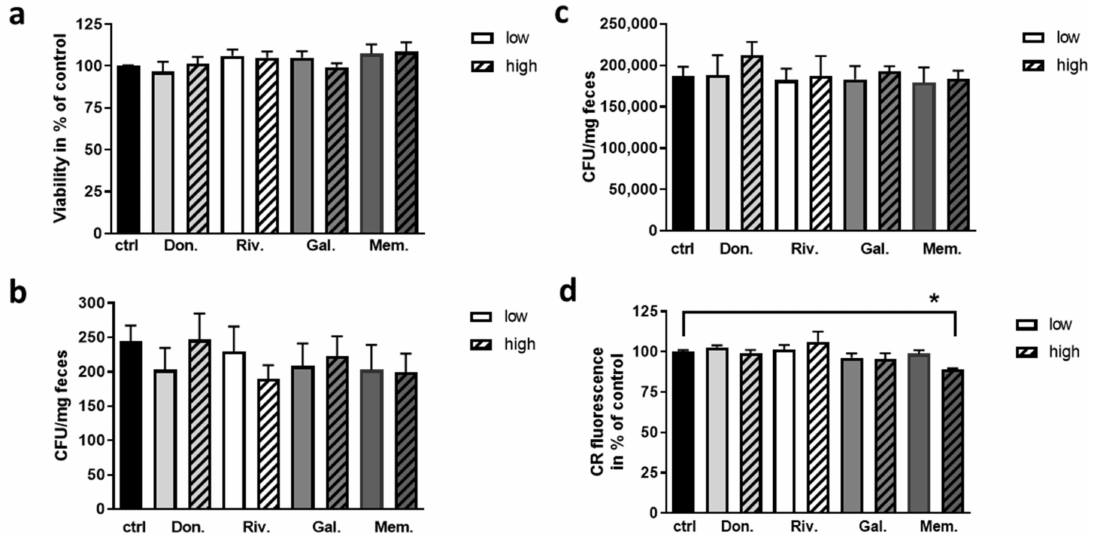
Figure 1. Effect of AD therapeutic drugs on growth and biofilm formation of bacteria. ( a ) Fresh fecal samples from wild type C57BL6/J mice were collected, diluted appropriately and incubated with the respective drug for 10 min (ctrl: DMSO; Don.: donepezil; Riv.: rivastigmine; Gal.: galantamine; Mem.: memantine; for the concentrations see Table 2). ( a ) ATP content was measured with the BacTiter-Glo assay ( n = 4; for each measurement performed in technical duplicates, fecal samples from 4 donor animals each were pooled; 50% females). Suspensions of fecal material were additionally plated after the incubation with the respective drug on family-specific plates. Colony forming units (CFU) were counted after 20 h of incubation for Enterobacteriaceae ( b ) and Lactobacillaceae ( c ). ( d ) Biofilm formation of E. coli was measured by assessment of the fluorescent signal of Congo red (CR) binding to amyloidogenic fibers within the biofilm derived by cultivation on YESCA-agar. Data are presented as mean + SEM. Statistical analysis was conducted by One Way ANOVA with Sidak’s multiple comparison test (* p < 0.05).